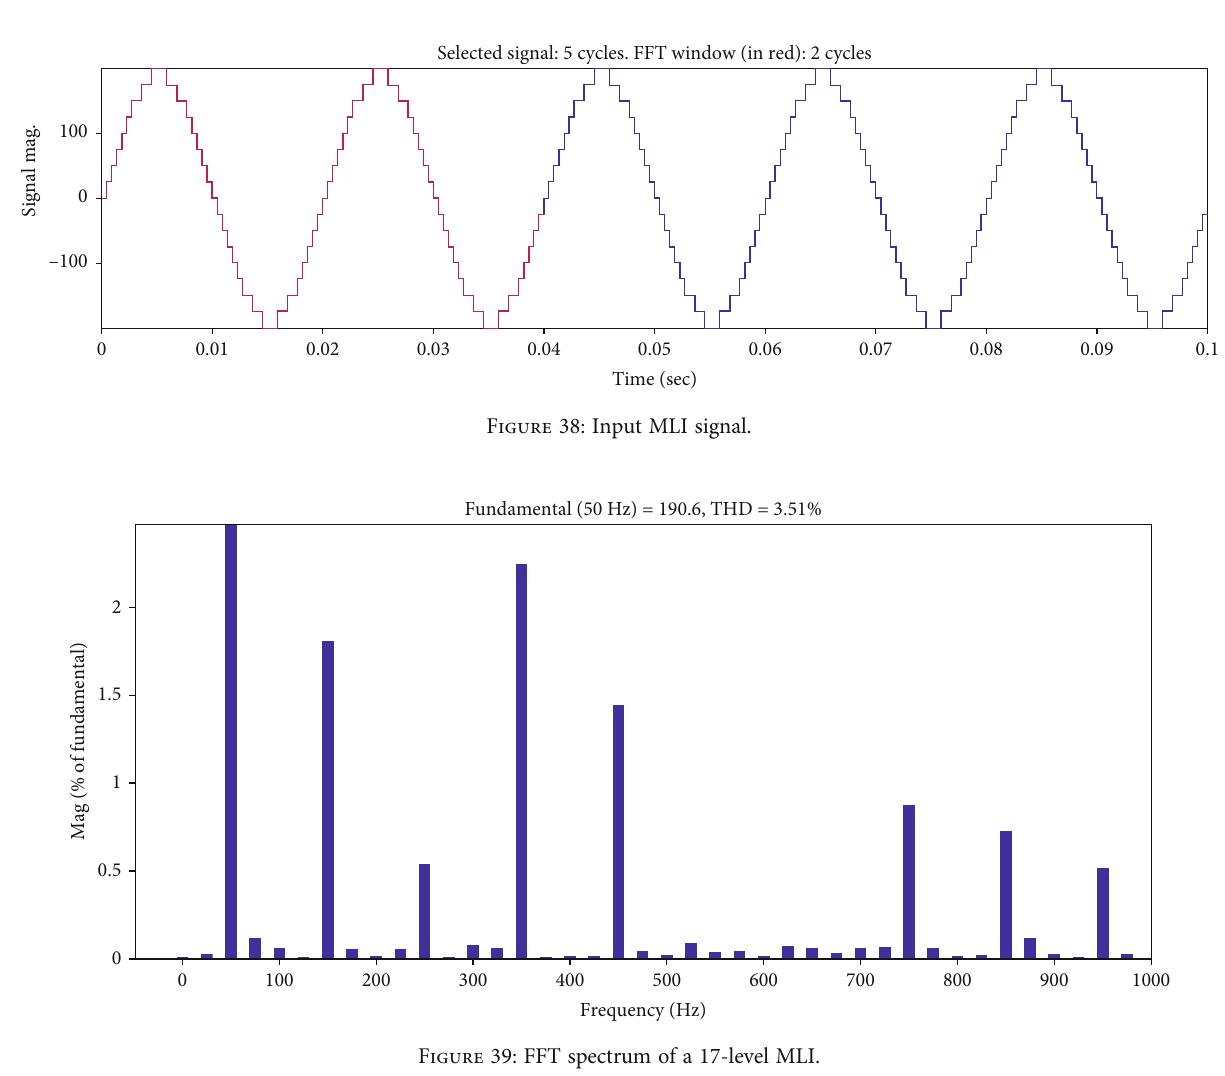
Figure 37: 3-phase MLI output with t = 0 : 1 and compared with sine wave.